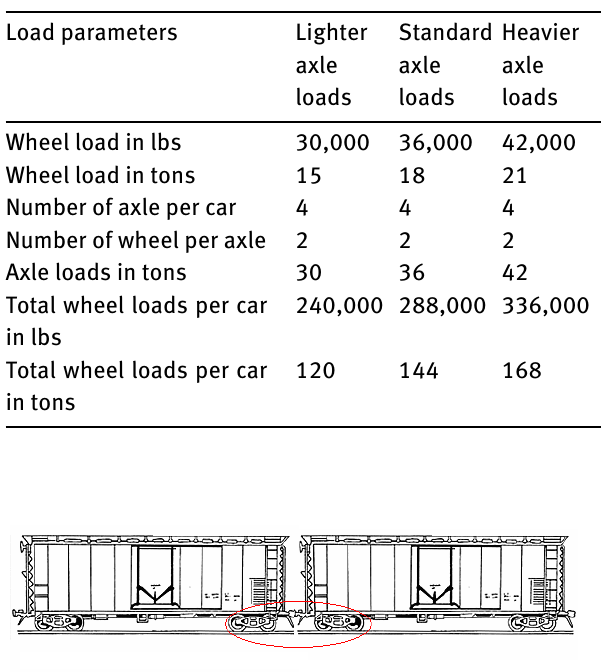
Table 1: Axle loads and wheel loads.